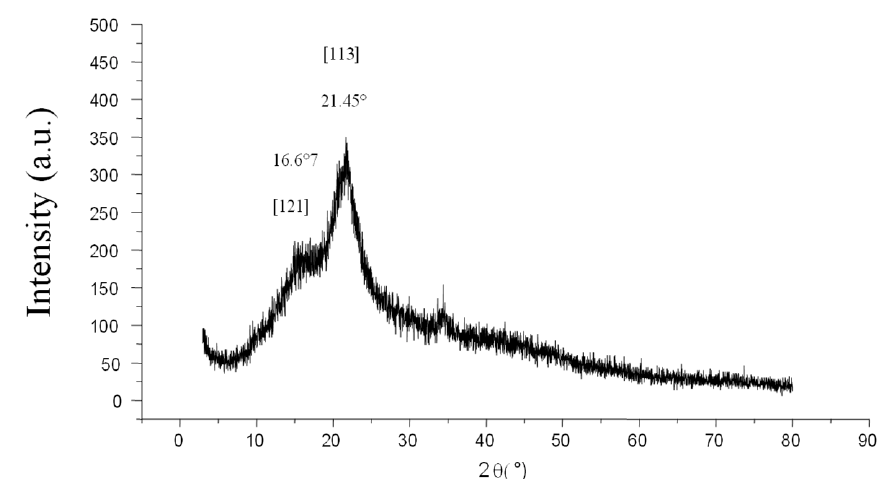
Figure 2. XRD analysis of AS.